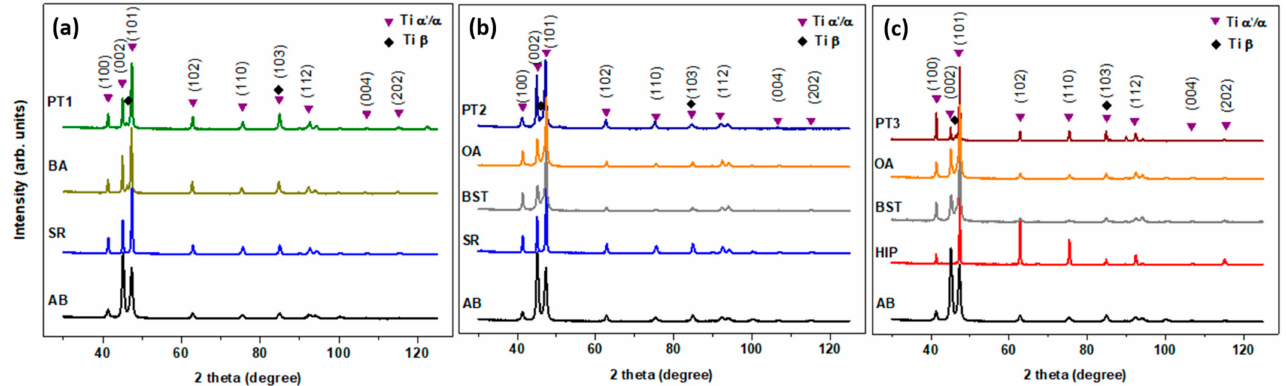
Figure 3. XRD patterns of the as-built and post-treated LPBF Ti64 specimens: ( a ) PT1, ( b ) PT2, and ( c )